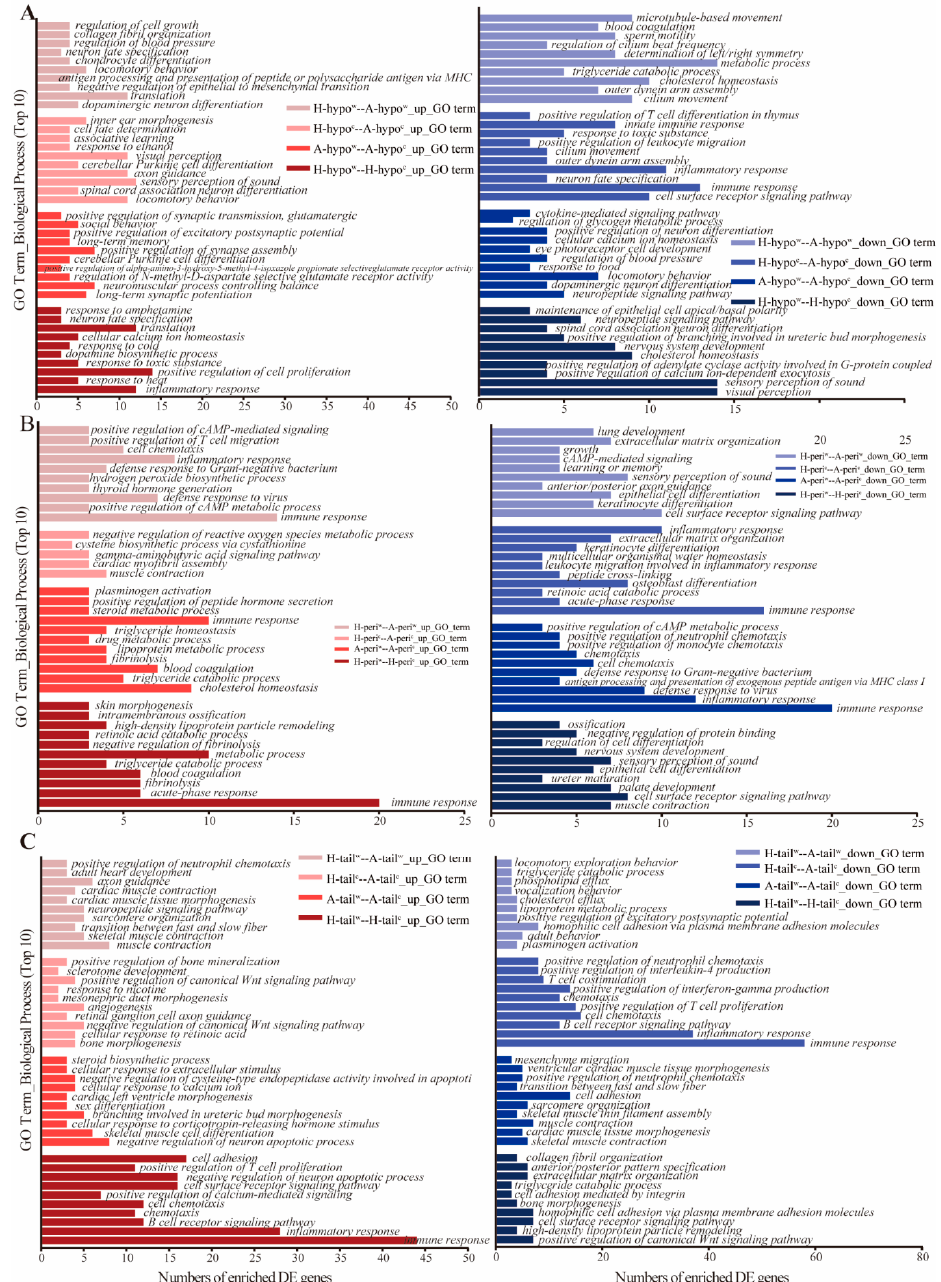
Figure 5. Top 10 up- and down-regulated DEGs enriched GO terms in different tissues and sheep breeds under cold exposure. ( A ): GO terms enriched in the hypothalamus, ( B ): GO terms enriched in the perirenal fat tissue, ( C ): GO terms enriched in the tail-fat tissue. H-hypow- A-hypow: hypothalamus tissue of the 20 ◦ C Altay lambs compared to the 20 ◦ C Hu lambs. H-hypoc- A-hypoc: hypothalamus tissue of the − 5 ◦ C Altay lambs compared to the − 5 ◦ C Hu lambs. H-hypow-H-hypoc: hypothalamus tissue of the − 5 ◦ C Hu lambs compared to the 20 ◦ C Hu lambs. A-hypow-A-hypoc: hypothalamus tissue of the − 5 ◦ C Altay lambs compared to the 20 ◦ C Hu lambs. H-tailw-A-tailw: tail-fat tissue of the 20 ◦ C Altay lambs compared to the 20 ◦ C Hu lambs. H-tailc-A-tailc: tail-fat tissue of the − 5 ◦ C Altay lambs compared to the − 5 ◦ C Hu lambs. H-tailw-H-tailc: tail-fat tissue of the − 5 ◦ C Hu lambs compared to the 20 ◦ C Hu lambs. A-tailw-A-tailc: tail-fat tissue of the − 5 ◦ C Altay lambs compared to the 20 ◦ C Hu lambs. H-periw-H-peric: perirenal fat tissue of the − 5 ◦ C Hu lambs compared to the 20 ◦ C Hu lambs. H-periw-A-periw: perirenal fat tissue of the 20 ◦ C Altay lambs compared to the 20 ◦ C Hu lambs. H-peric-A-periw: perirenal fat tissue of the − 5 ◦ C Altay lambs compared to the − 5 ◦ C Hu lambs. A-periw-A-peric: perirenal fat tissue of the − 5 ◦ C Altay lambs compared to the 20 ◦ C Hu